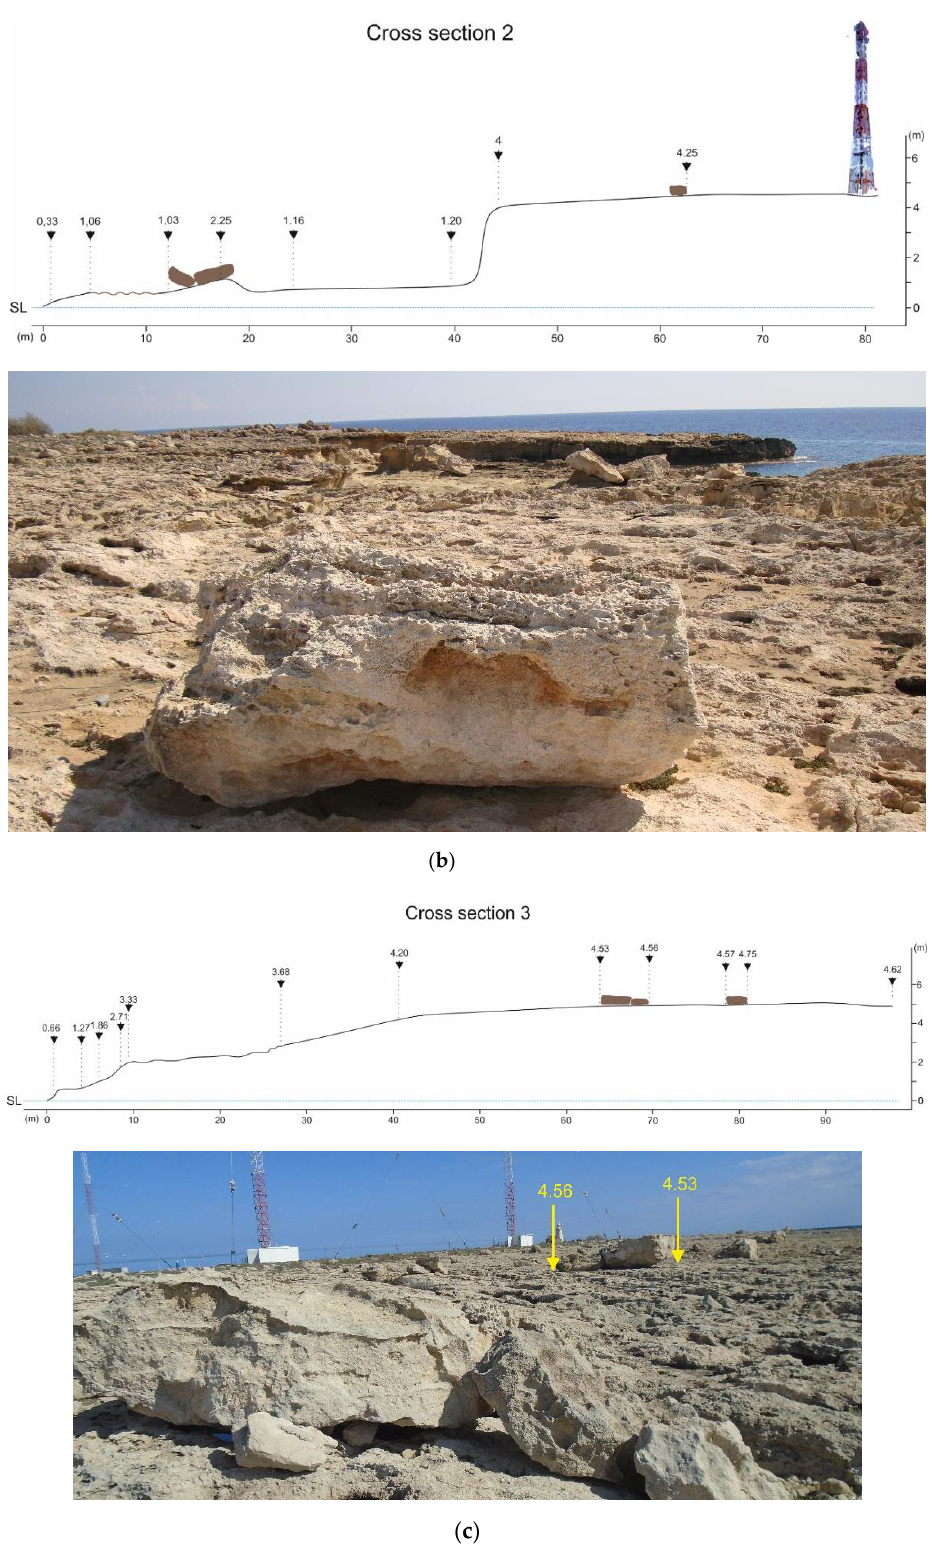
Figure 7. Topographic sections of the study area (SL is sea level, dashed lines with arrows show the elevation); ( a ) Cross Section 1 and a corresponding photograph as viewed from the SW; ( b ) Cross Section 2 and the boulder located at about 4.25 m elevation; ( c ) Cross Section 3 and a corresponding photograph. The cross-section traces are shown in Figure 5.